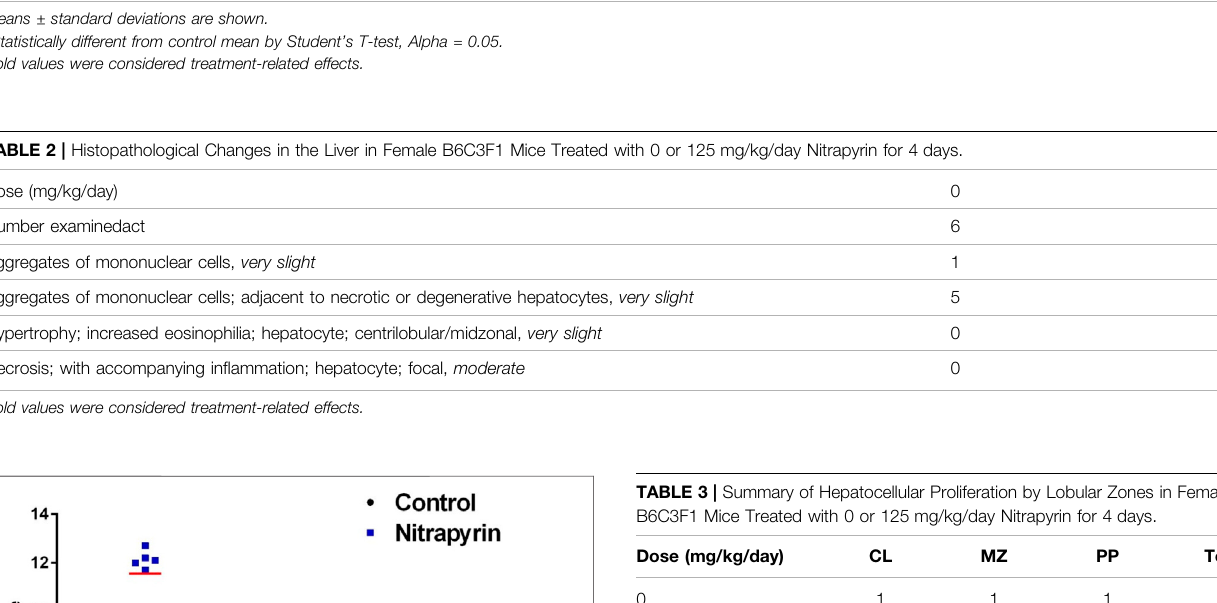
TABLE 1 | Absolute (g) and Relative Liver Weights (g/100 g body weight) in Female B6C3F1 Mice Treated with 0 or 125 mg/kg/day Nitrapyrin for 4 days. 0 mg/kg/day ( n = 6) 125 mg/kg/day ( n = 6) Absolute Liver Wt. (g)